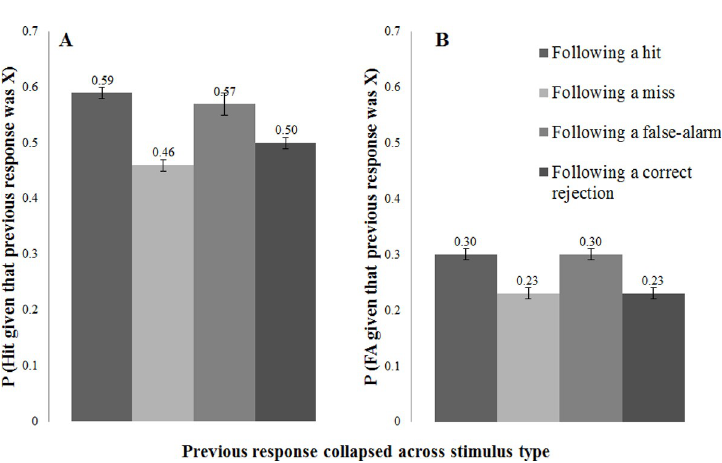
Fig 2. Experiment 3: Hit rate and false-alarm rate contingencies. Panel A displays the probability of a hit on the current trial given the previous response (hit, miss, false alarm, or correct rejection), collapsed across stimulus type (faces, places, words). Previous responses of hit and false alarm do not significantly differ from each other, but all other comparisons are significant ( ps < .001). Panel B displays the probability of a false alarm on the current trial given the previous response, collapse across stimulus type. A false alarm on the on the current trial is significantly more likely given a previous hit or false alarm when compared with a previous miss or correct rejections ( ps < .001). Error bars are with standard